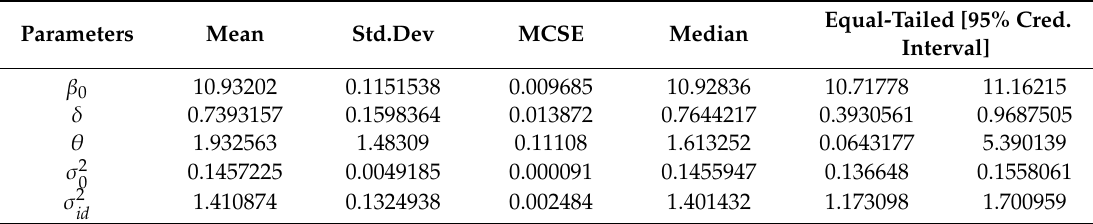
Table 3. Estimation results of the model.